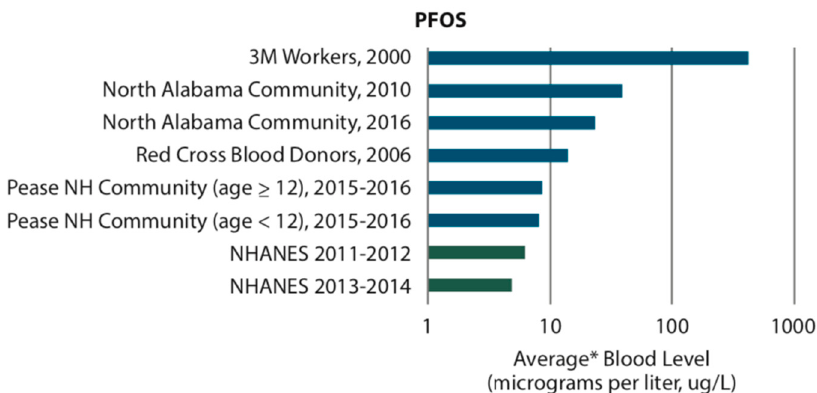
Figure 1. Blood levels in people who were exposed to perfluorooctanoic acid (PFOA, upper panel) and perfluorooctane sulfonic acid (PFOS, lower panel) [26]. Figure 1 references: 3M Workers, 2000 [74]; Dupont Workers, 2004 [75]; Little Hocking Community, 2005-2006 [76]; Ohio River Valley Community, 2005-2006 [77]; North Alabama Community [78]; Pease NH Community [79]; Red Cross Blood Donors, 2006 [80]; NHANES [25].